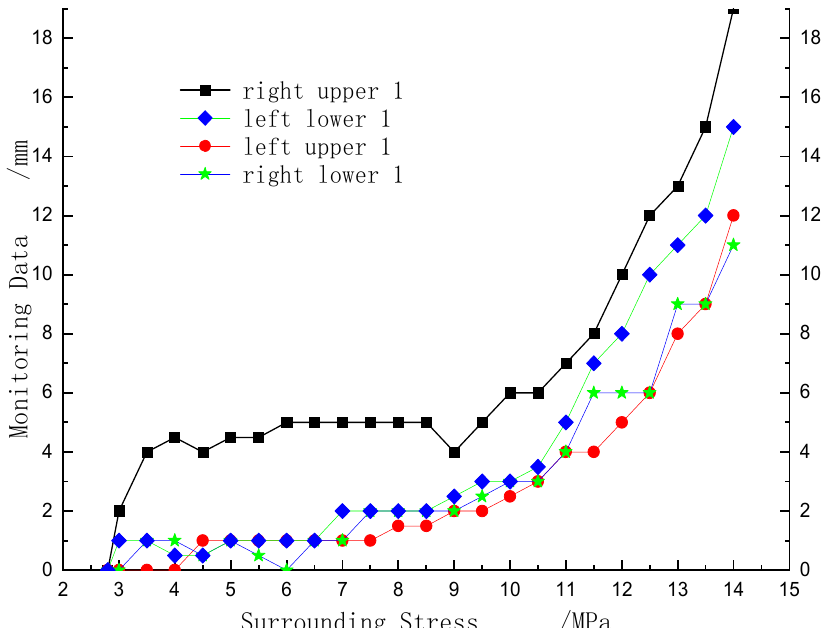
Figure 10. Displacement comparison of roadway-surrounding-rock monitoring points.